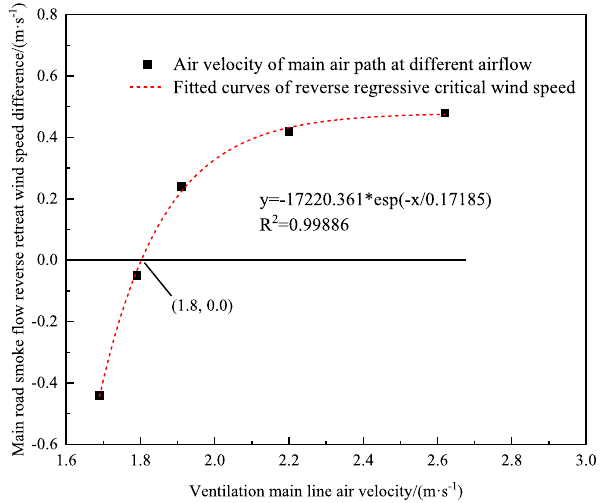
Figure 7. Determination of the critical wind speed for the turbulence in downward fire experiments.